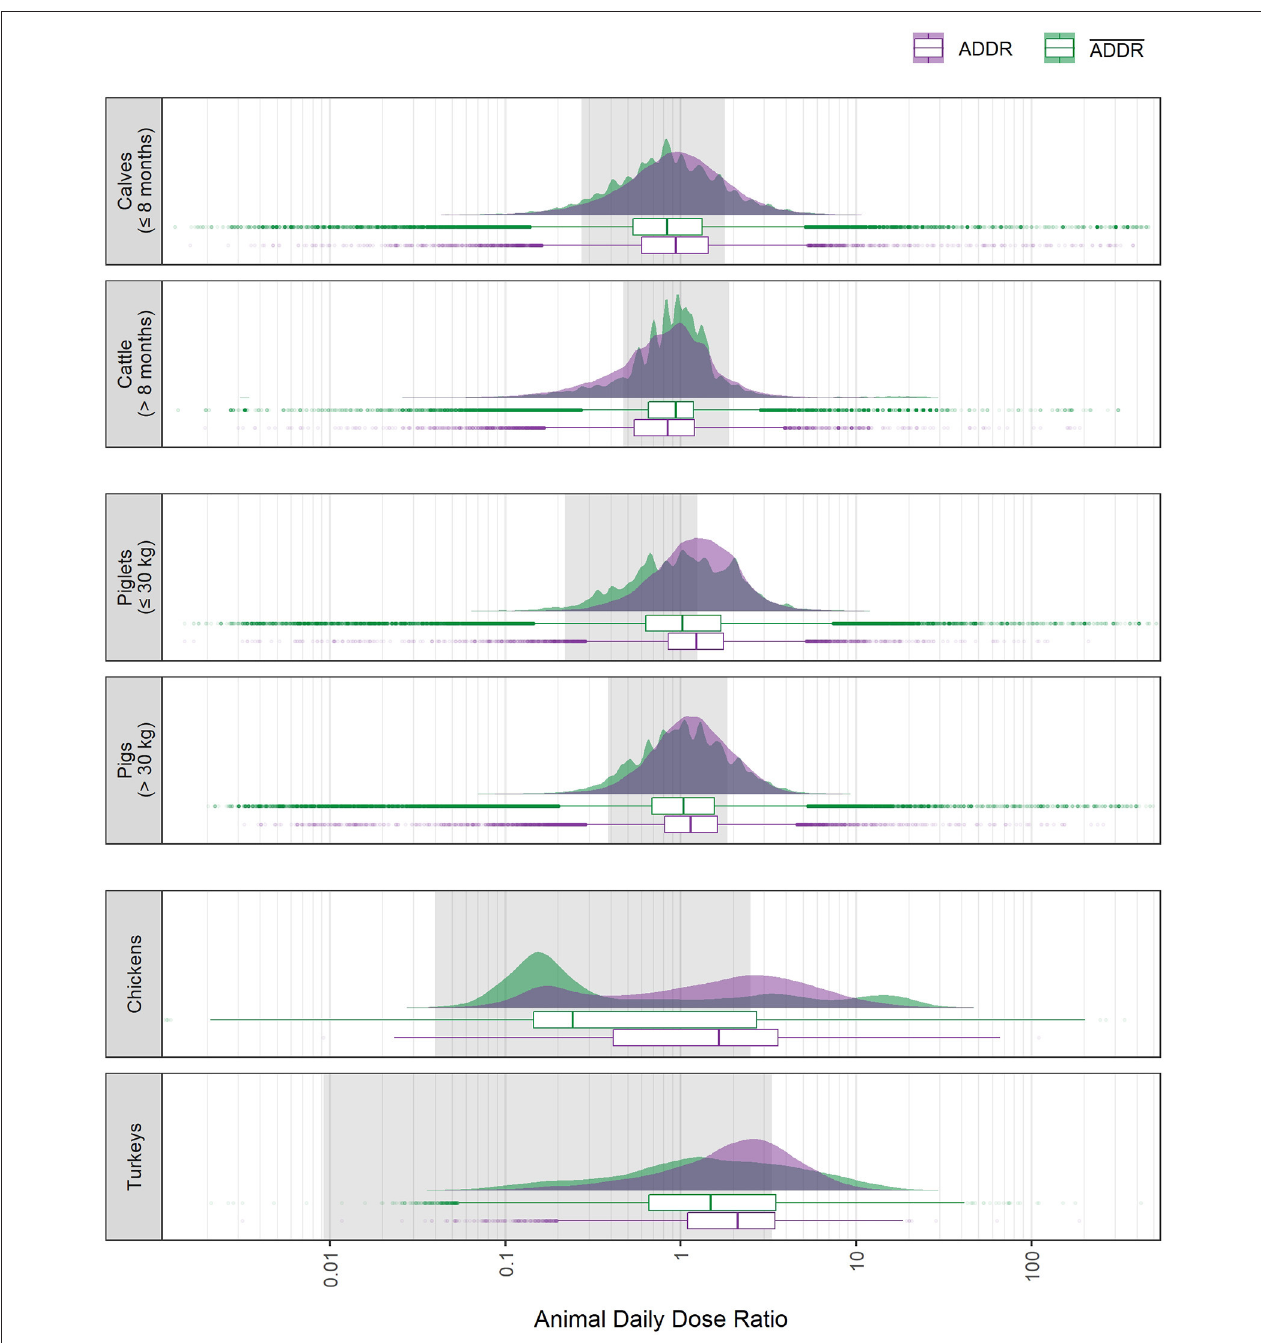
FIGURE 5 | Distribution of the animal daily dose ratio at the individual treatment level (ADDR, purple) and at the farm level (ADDR, green) for each of the six animal populations covered by the German benchmarking system. The regions shaded in gray indicate the weight ratio range for each of the animal populations (compare Table 1 ). The abscissa is log-scaled. Data is from all half-year periods 2014-2 to